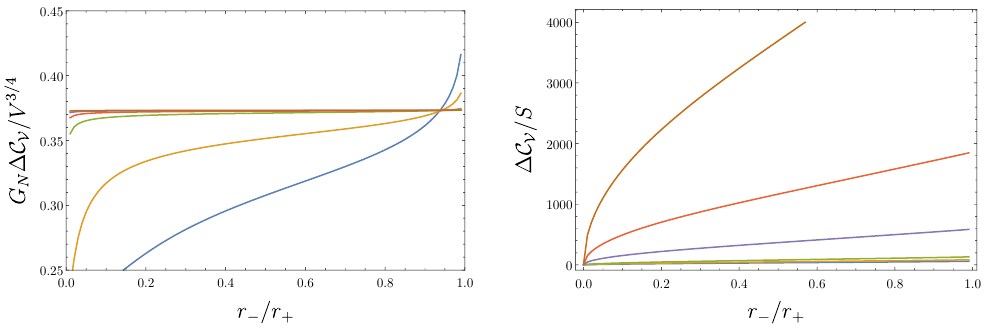
Figure 9. Here we show the complexity of formation within the CV proposal normalized by the thermodynamic volume (left) and by the entropy (right). In each case the curves correspond to r + /‘ = 10 , 10 2 , 10 3 , 10 4 , 10 5 , 10 6 , 10 7 (in order from bottom to top) for D = 5 . is controlled by the thermodynamic